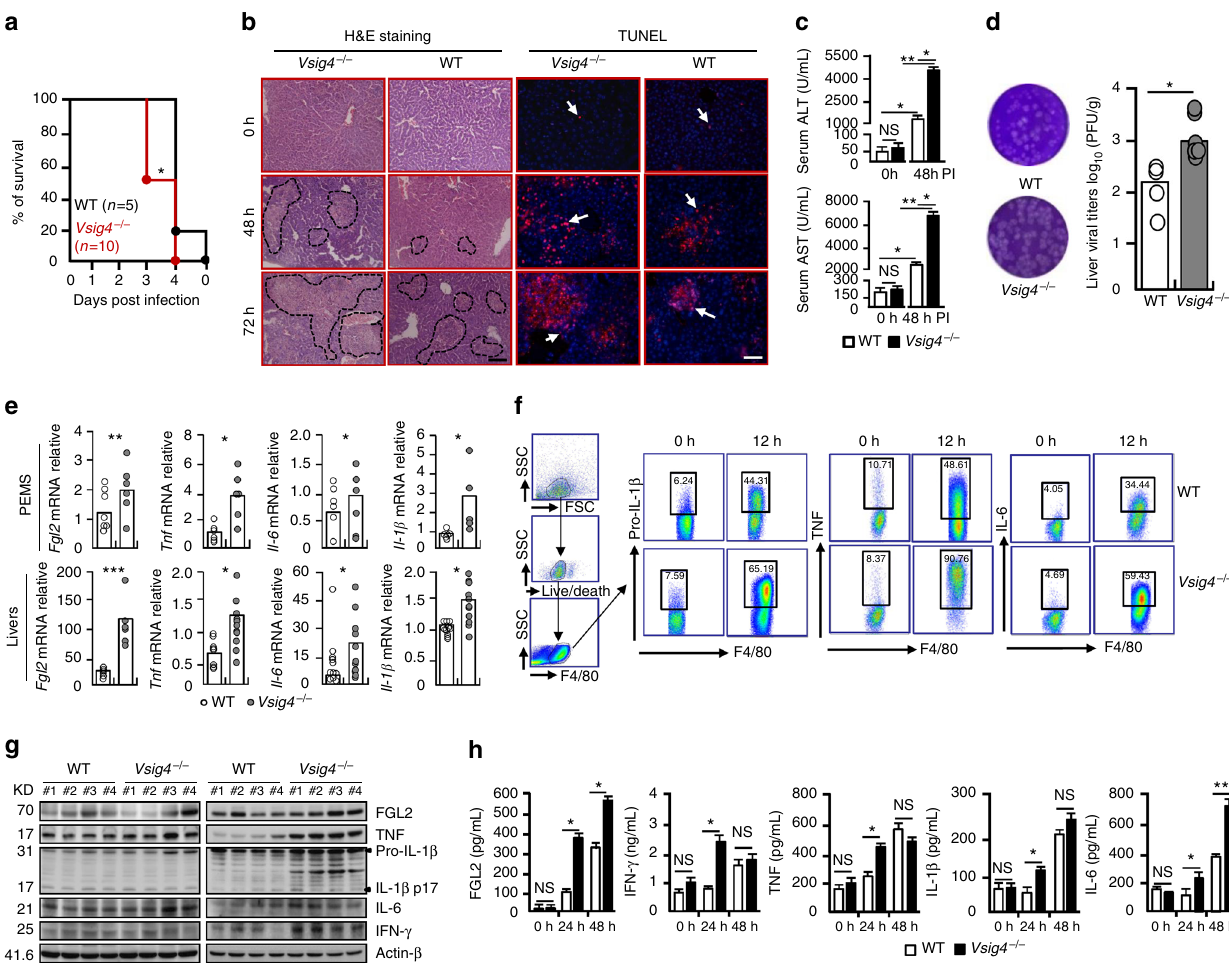
Fig. 2 Vsig4 de fi ciency exacerbates MHV-3-induced fulminant hepatitis. The Vsig4 − / − mice and age-matched C57BL/6 WT littermates were infected with MHV-3 (100 PFU/mouse) via i.p. injection. a The survival was monitored. b H&E staining of liver, and TUNEL staining of cell apoptosis, scale bar = 20 μ m, n = 5 – 8 per group, arrow indicated positive cells. c Serum ALT and AST levels at 0 h and 48 h post infection (PI), n = 5 – 8 per group. d Plaque assay of virus titers in livers at 48 h PI. e qRT-PCR analyzing proin fl ammatory cytokines in PEMs at 12 h and in liver tissues at 72 h of MHV-3 infection. f Flow cytometry analyzing TNF, pro-IL1- β , and IL-6 from PEMs after 12 h of virus infection. g Western blot analyzing proin fl ammatory cytokines in infected livers at 24 h and 48 h PI, n = 4 per group. h ELISA of serum concentration of proin fl ammatory mediators, n = 5 – 10 per group. Error bar, s.e.m. * p < 0.05, ** p < 0.01, *** p < 0.001 and NS, p > 0.05. a was analyzed by log-rank test and others are calculated by Student ’ s t -test. Data are representative of six ( a ) and three ( b – f , h